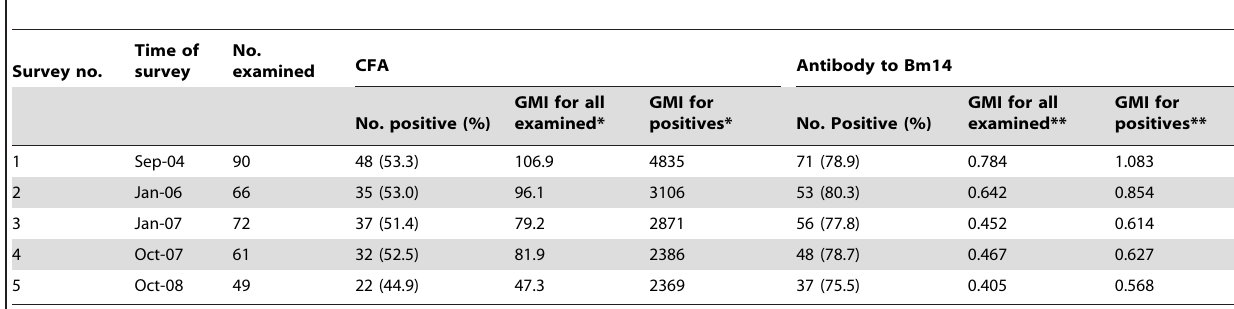
Table 5. Circulating filarial antigen (CFA) and antibody to Bm14 in 90 volunteers from the mosquito collection houses in Kirare village.